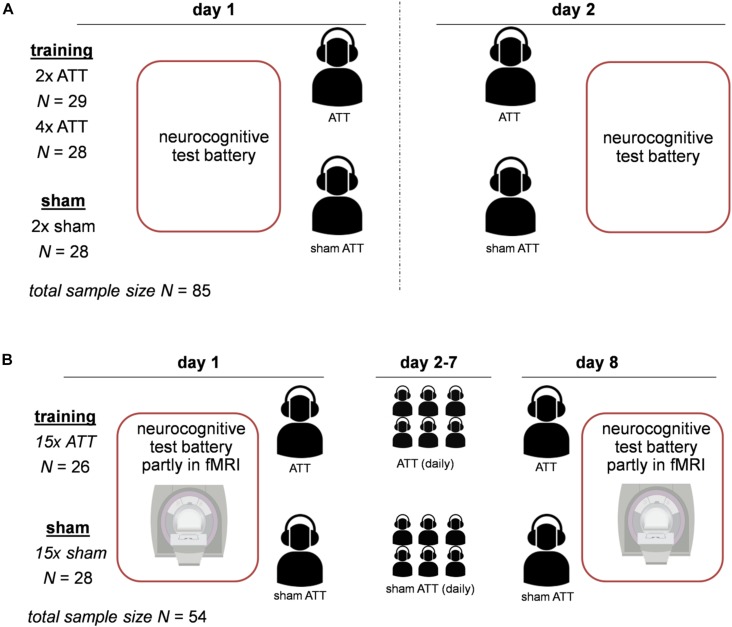
Experimental design for both studies. Panel (A) displays the design of study 1; Attentional Training Technique (ATT)/sham ATT was performed on two consecutive days. Panel (B) shows the design of study 2; ATT/sham ATT was performed on day 1 and day 8 in the lab, and in between (day 2–day 7), subjects were trained with ATT/sham ATT at home.